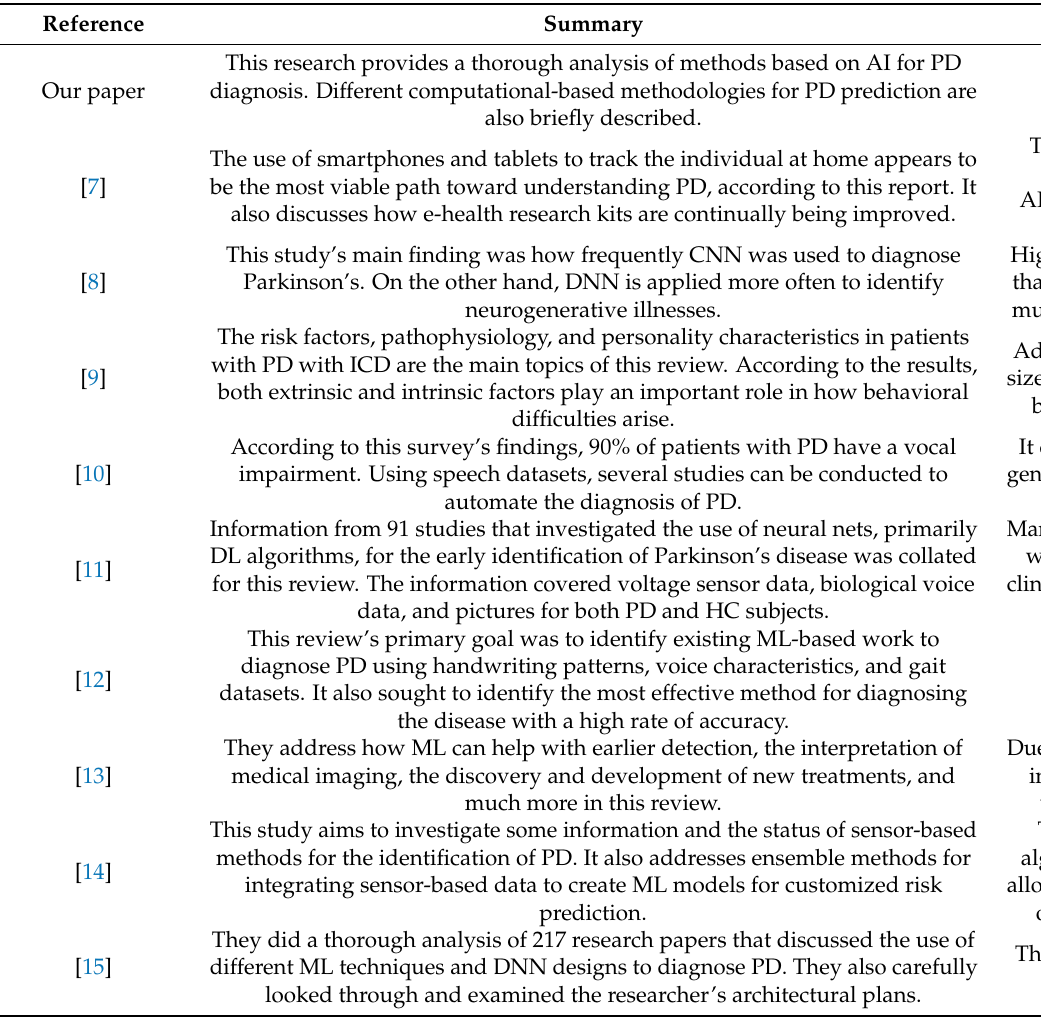
Table 2. Comparison with previous surveys/Comparison with other similar review articles (H—High-level discussion, M—Moderate-level discussion, L—Low-level discussion, N—Not